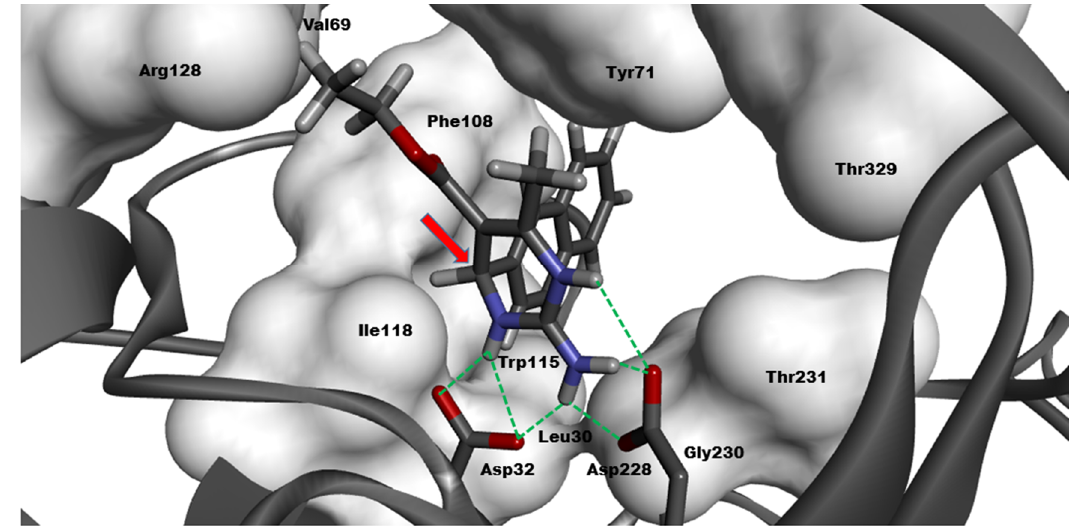
Figure 3. Best docking pose of ( R ) - 10c and its interactions with BACE-1. Red arrow: the stereogenic center of the inhibitor.